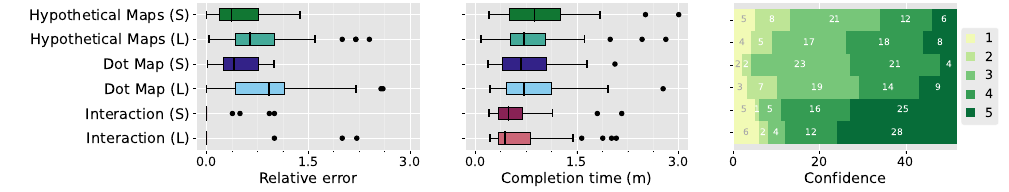
Figure 8. Results of the task measuring the impact of the distance between geographical regions.